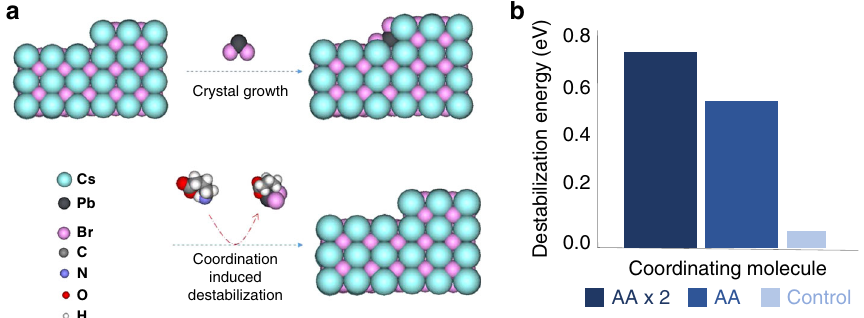
Fig. 2 Control of 2D perovskite crystallization using a chelating agent. a Schematic of the chelating effect on PbBr 2 binding to the surface. b DFT- calculated destabilization energy of PbBr 2 on the surface of perovskite when coordinated with 2 GABA molecules, 1 GABA molecule, and